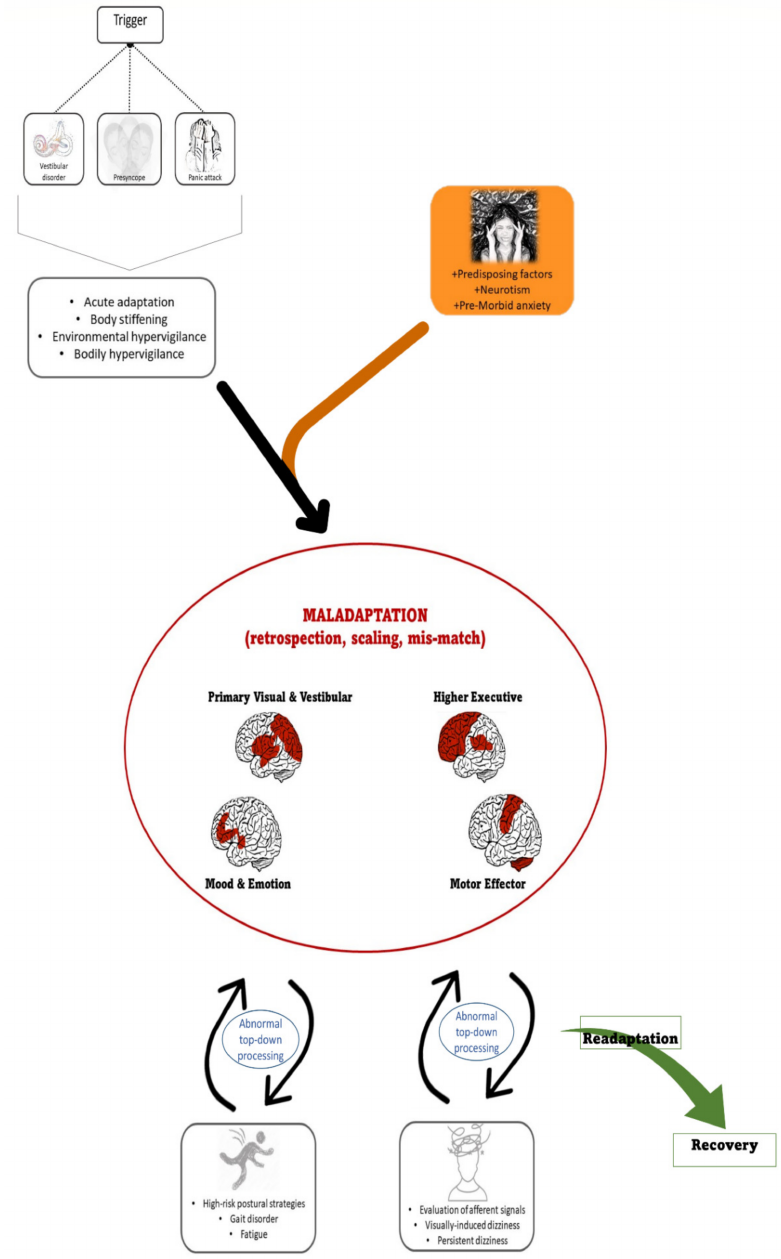
Figure 1. Pathophysiology of persistent postural-perceptual dizziness and neural networks involved. A triggering event may lead to an acute adaptation phase with transient behavioural and perceptual changes. In the context of predisposing psychological factors, such an adaptation becomes a maladap- tive strategy, involving abnormal interactions between primary visual and vestibular cortices, higher executive cortical areas, limbic structures that process mood and emotion, and motor efferent areas. Maladaptation induces heightened introspection and abnormal interpretation of afferent sensory signals (sensory scaling mis-match), which drives typical symptoms of PPPD, including visually induced dizziness, persistent dizziness, gait disorder, and cognitive